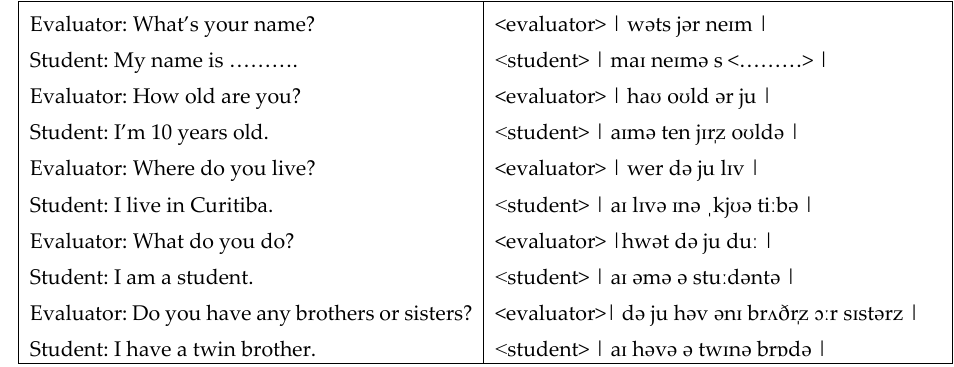
Table 5. Transcript 5. Evaluator: What did you do last Saturday? Student: I went to a shopping mall and bought a pair of shoes. Evaluator: What did you do on Sunday? Student: I went to church and prayed. Evaluator: What did you do yesterday? Student: I went to the park to run. Evaluator: Where did you go on your last vacation? Student: I went to the beach. Evaluator: Where did you live when you were a child? Student: I lived in São Paulo.